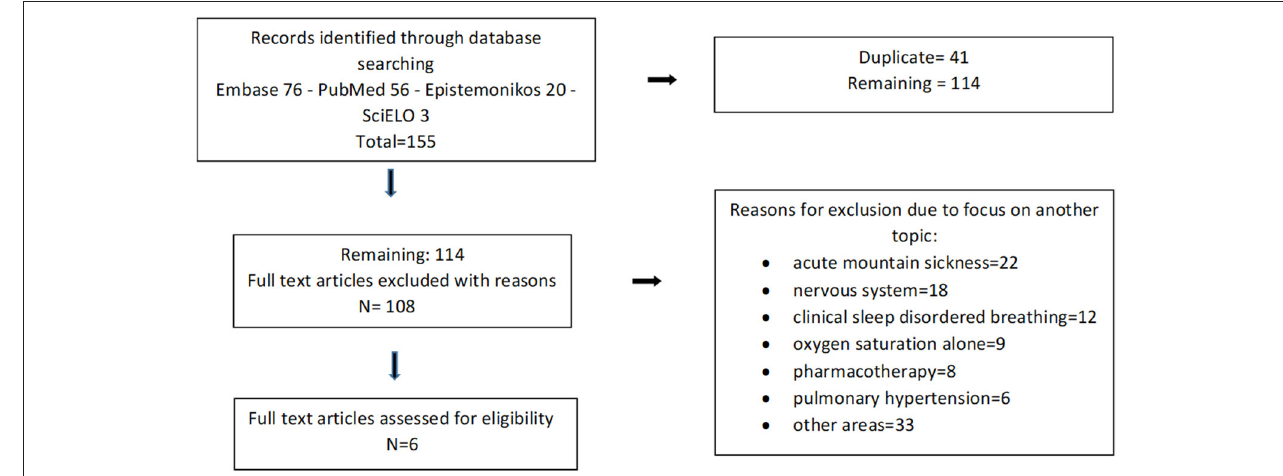
FIGURE 1 | Process of study selection.